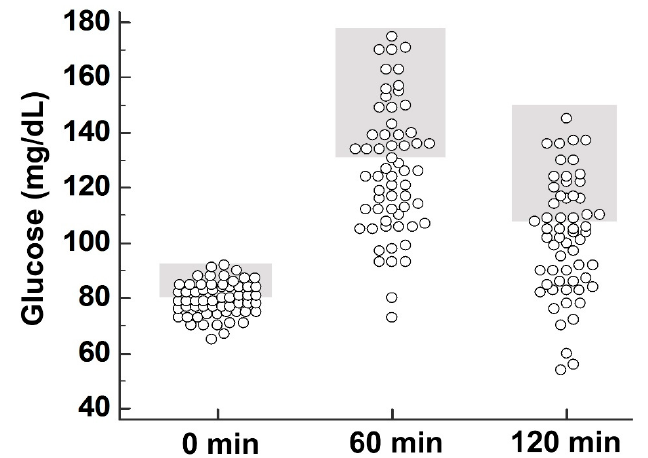
Figure 2. Results of the oral glucose tolerance test with 75 g of glucose. Glucose values at 0 min, 60 min, and 120 min. Marginal values per HAPO category 3 and higher are shown in